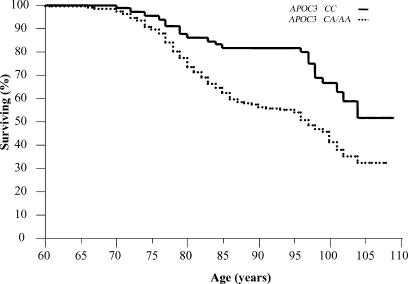
Survival Analysis according to
APOC3 Genotypes
Of the 381 participants we genotyped since 1998, 64 had the −641 CC genotype. To describe the relationship between genotype and death, we plotted the Kaplan–Meier survival function estimates of probands and controls by
APOC3 genotype. Offspring were excluded in this analysis because all participants are currently alive and offspring genotype/phenotype is not independent of the probands.
Log-Rank (
p = 0.0008); Wilcoxon (
p = 0.0007).
CC, homozygous for (−641) C; CA/AA, homozygous and heterozygous for (−641) A.